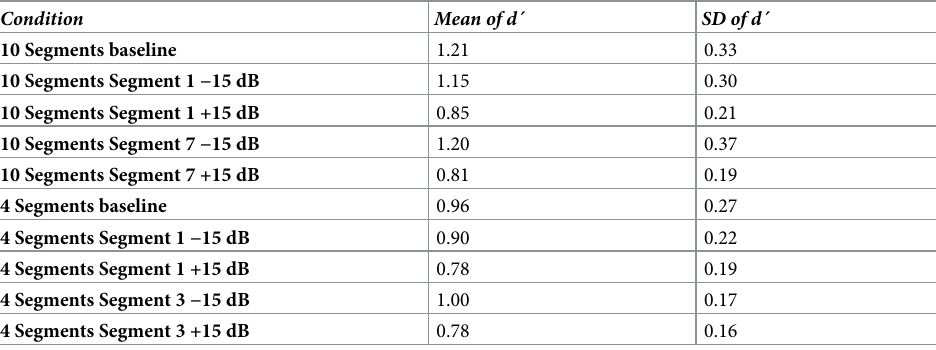
Table 3. Mean sensitivity ( d´ ) across listeners in the ten different conditions of Experiment 2. N = 10.